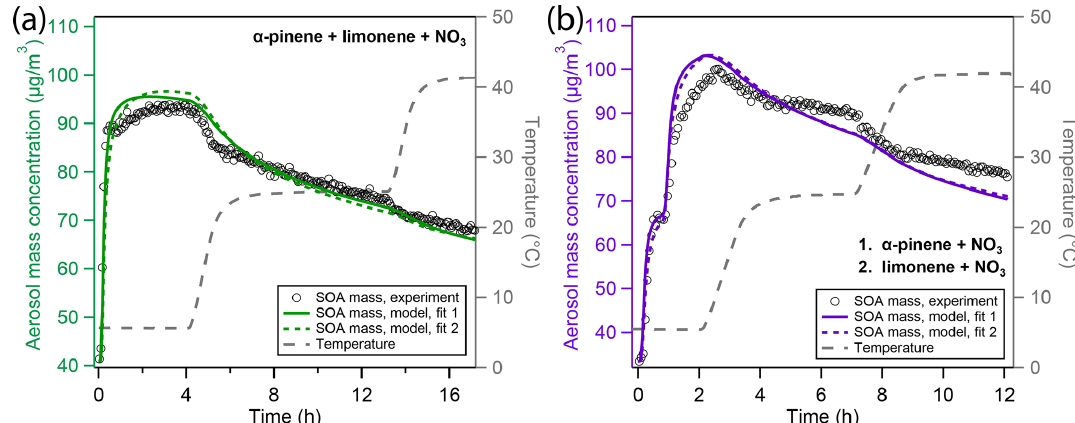
Figure 4. Overview of experimental and modeling results of aerosol mass for experiments with mixed monoterpene precursors. The exper- iments in the two panels differ in the way the precursors were added: (a) simultaneous oxidation of a mixture of α -pinene and limonene; (b) sequential oxidation of firstly α -pinene and secondly limonene with NO 3 . Open black markers are experimental aerosol mass obtained using an SMPS. The colored solid and dotted lines represent model results from two different fits to the experimental data. The grey dashed line indicates the experimental temperature